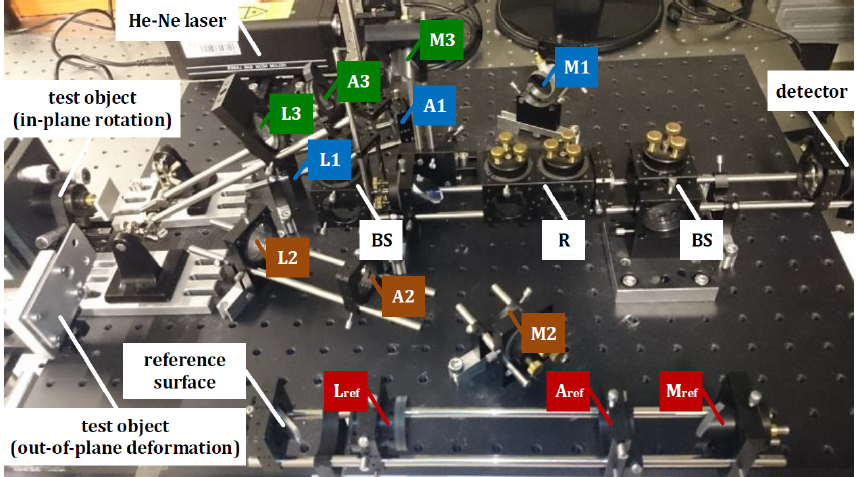
Figure 2. Experimental setup of online 3D displacement measurement (BS: beam splitter; L: lens; A: single aperture; M: plane mirror; R: